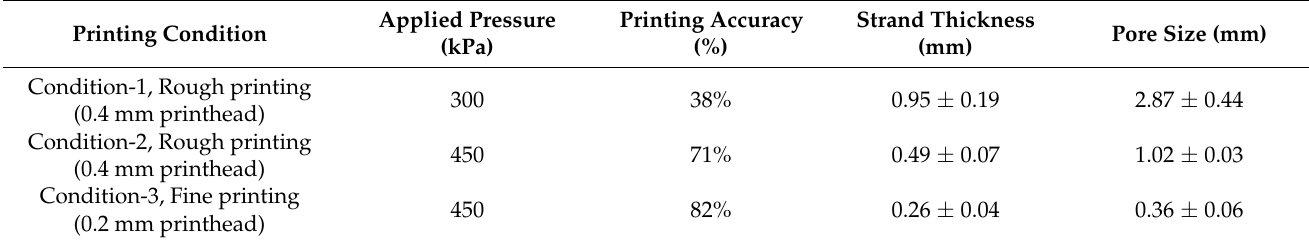
Figure 10. MCL-PHA terpolyester scaffolds fabricated by various conditions (Table 3): ( a ) Condition-1, ( b ) Conditon-2, and ( c ) Condition-3. Table 3. Printing accuracy and fiber characteristics of MCL-PHA terpolyester scaffolds fabricated using 3D-printing at the operation temperature of 130 ◦ C with 3 mm/s of printing